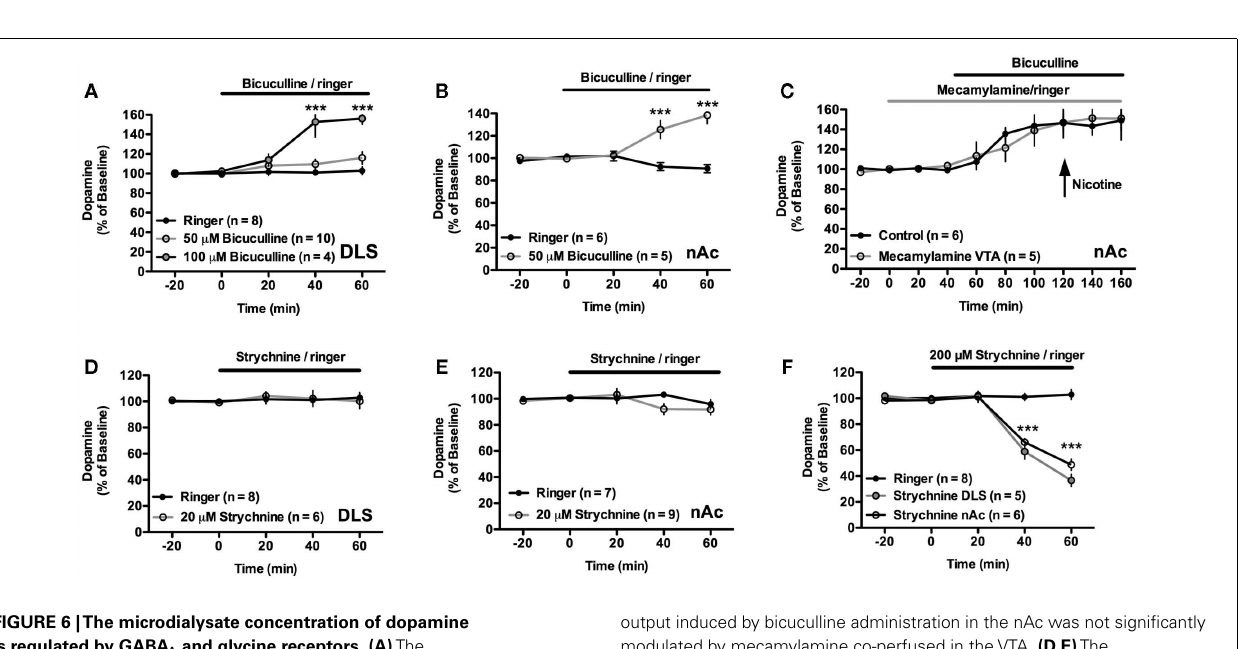
FIGURE 6 |The microdialysate concentration of dopamine is regulated by GABA A and glycine receptors. (A) The microdialysate concentration of dopamine was significantly enhanced by 100 μ M but not by 50 μ M bicuculline in the DLS. (B) Bicuculline (50 μ M) applied by reversed microdialysis in the nAc enhanced the extracellular level of dopamine. (C) The increase in dopamine